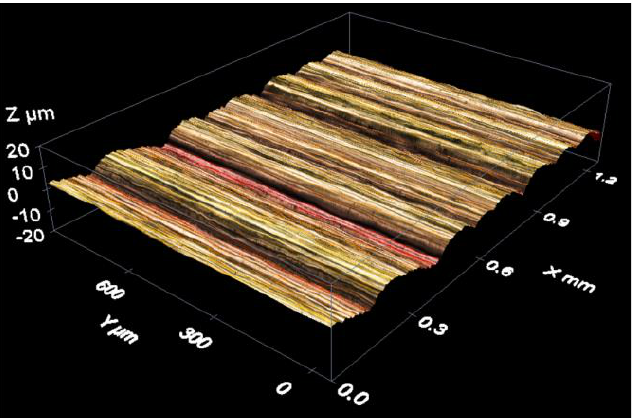
Figure 5. 3D reconstruction of the standard surface measured with a confocal microscope.